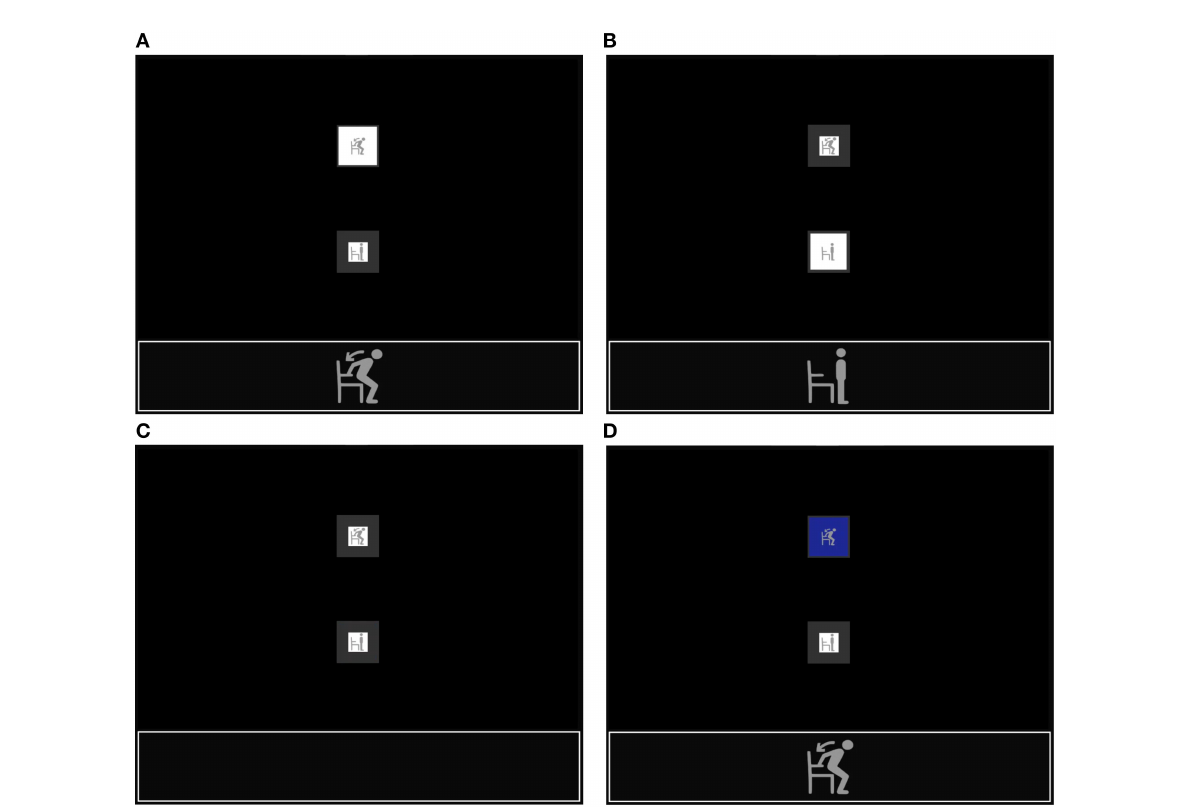
FIGURE3 Continuous visual feedback during the online stand-to-sit experiment when: (A) the BCI has detected a high MI-related activity, (B) the BCI has detected a high idle state-related activity, (C) the BCI has not detected a dominant experimental task, and (D) the BCI has detected a dominant experimental